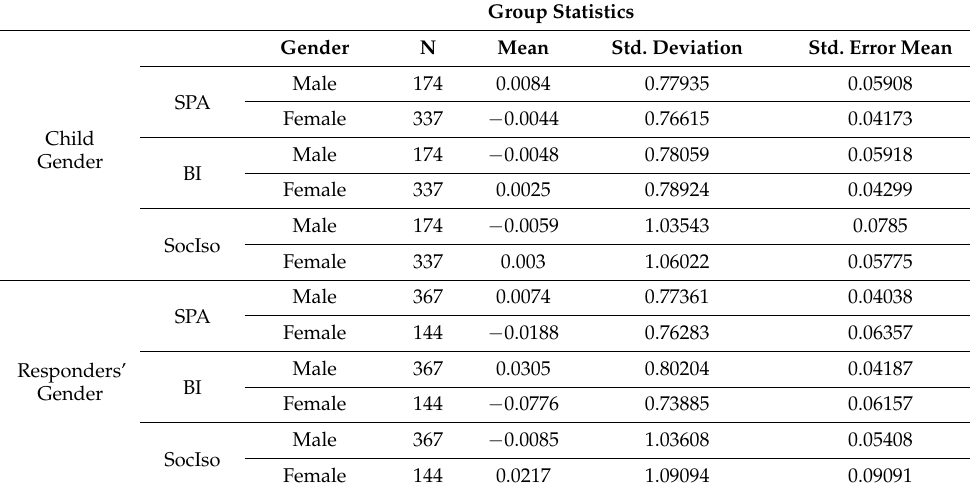
Table 11. Group statistics of children’s and responders’ gender.